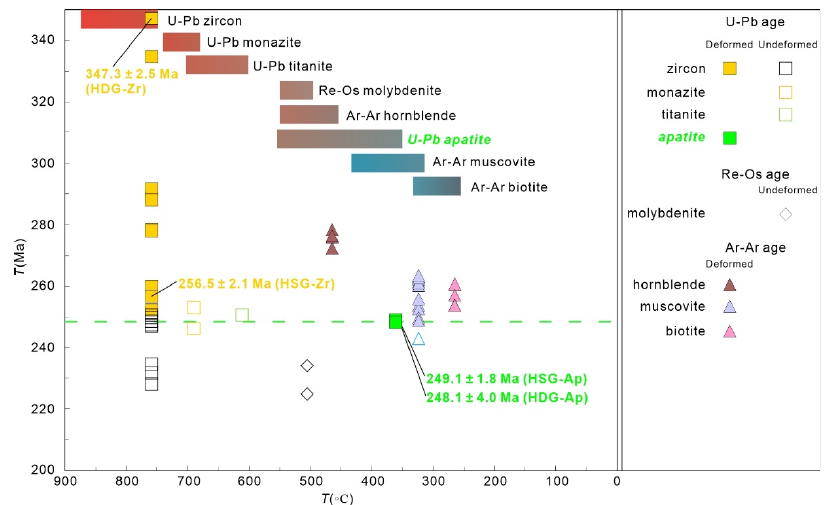
Figure 11. Isotopic ages and closure temperature of isotopic system. The closure temperature data of isotopic system are modified from Chew et al. [40].